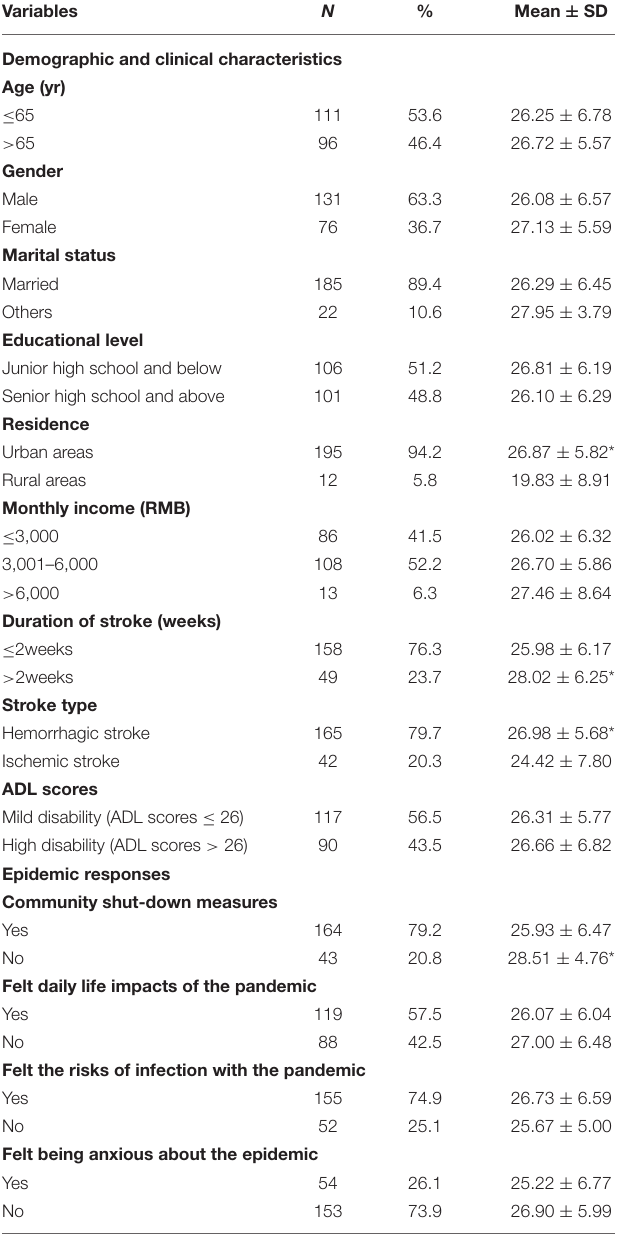
TABLE 1 | Characteristics of the stroke patients and distributions in life satisfaction ( N = 207).